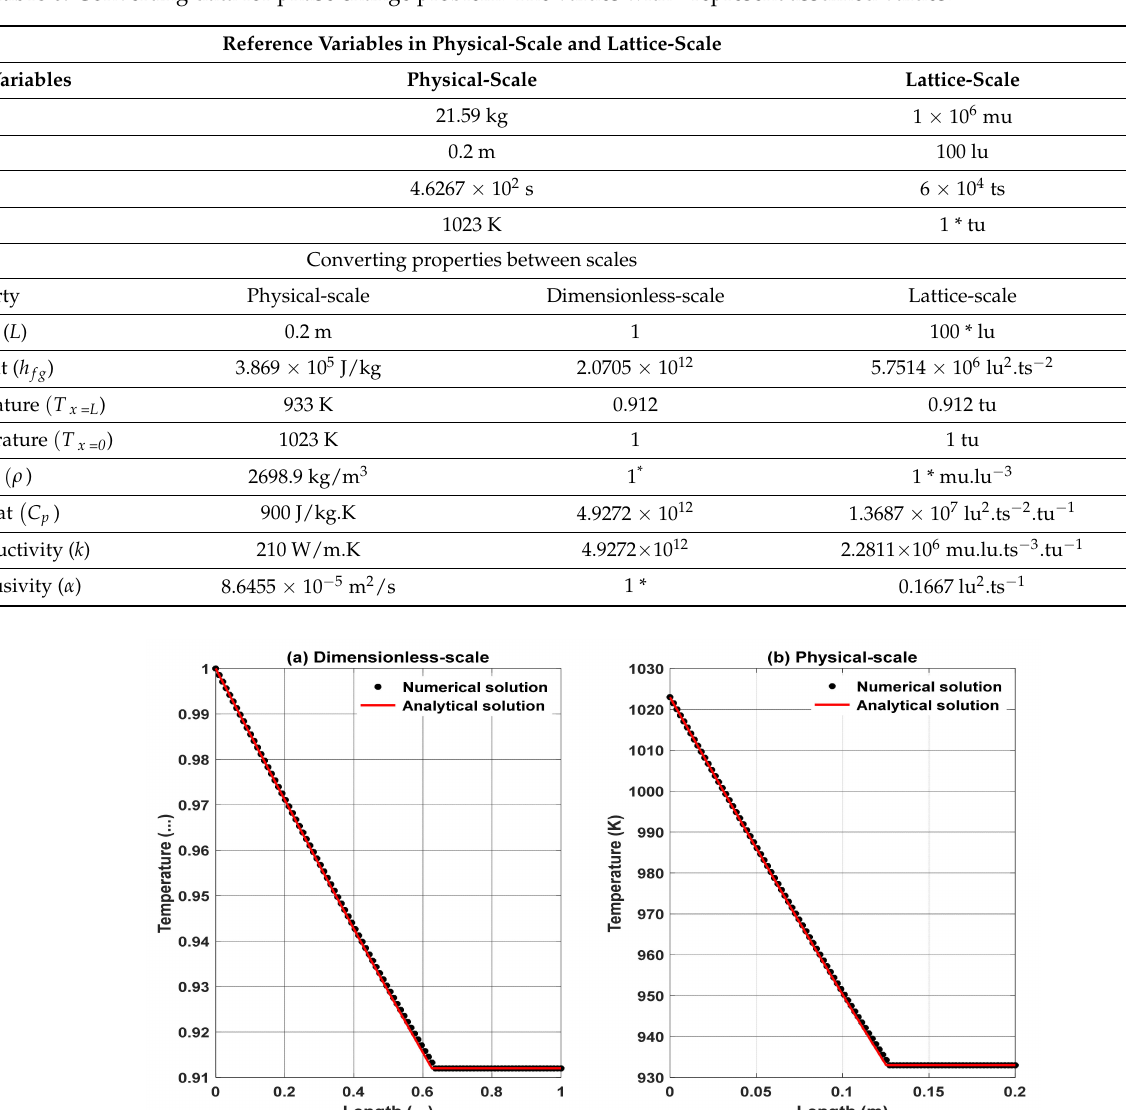
Table 6. Converting data for phase change problem. The values with * represent assumed values.